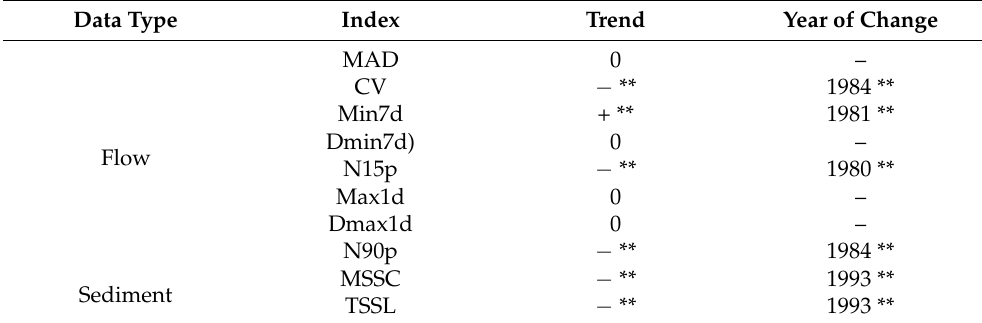
Table 2. Trend and change-points in flow series detected by the MK test and Pettitt test.